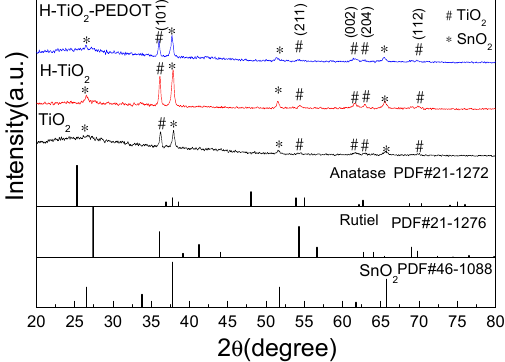
Figure 1. XRD patterns of TiO 2 , H-TiO 2 , and H-TiO 2 -PEDOT.